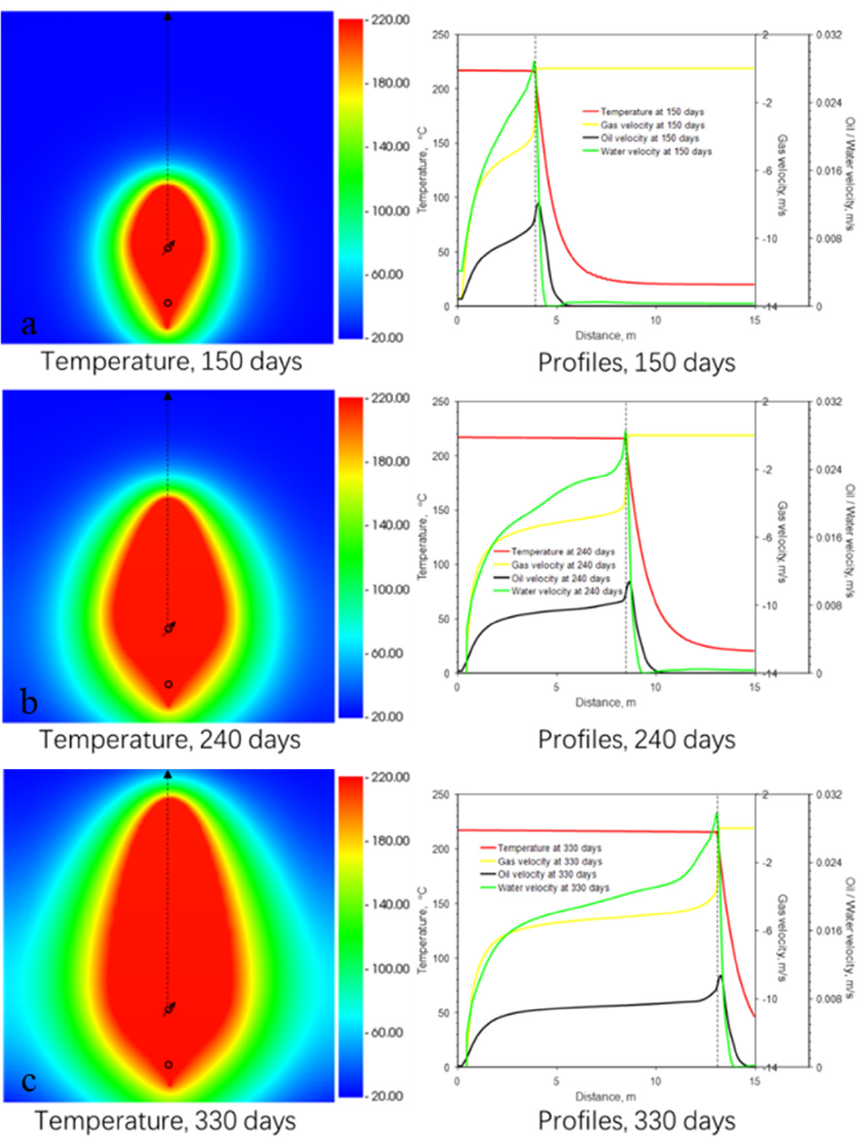
Figure 11. Characteristics of the steam chamber ramp-up phase at ( a ) 150 days, ( b ) 240 days and ( c ) 330 days: (left) cross-sectional temperature distributions; (right) temperature and the vertical flow velocities of gas, water and oil along the line from the injection well to the top of the reservoir.